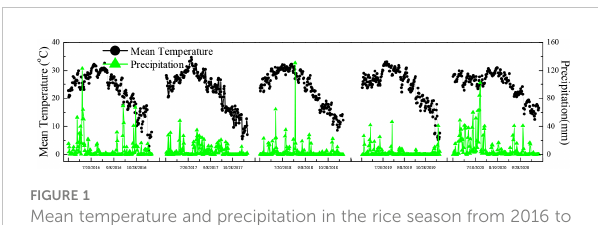
FIGURE 1 Mean temperature and precipitation in the rice season from 2016